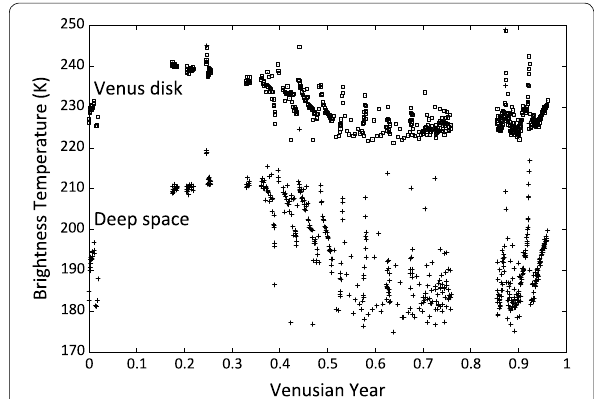
Fig. 2 Temperature variations of the Venus disk and the deep space derived from images obtained by LIR during the first Venusian year after the orbit insertion. The short‑term variation that has a period of 0.045 Venusian years is coincident with the orbital period of approxi‑ mately 10 earth